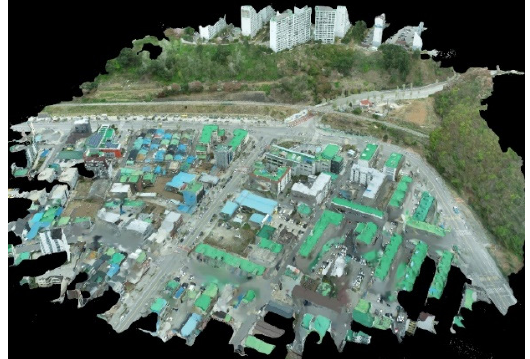
Figure 10. 3D model of the study area.